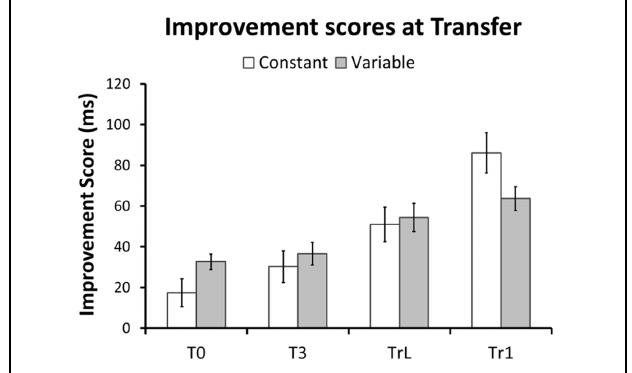
FIGURE 4 | Performance improvements at Transfer. Improvements in RT are shown as between-participant means of the within-participant difference between median RT at Baseline and Transfer. Note that in both groups and for all sequences RTs improved after training. Error bars represent standard error of the mean. TABLE 2 | Response times per group during Baseline and Transfer